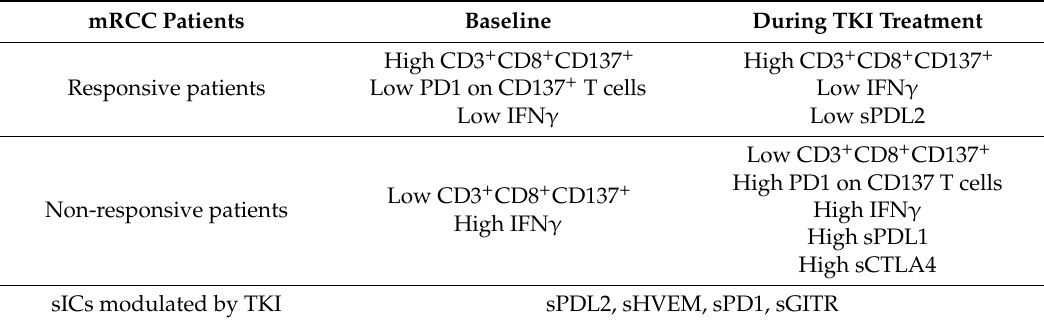
Table 2. Circulating biomarkers modulated in mRCC patients.